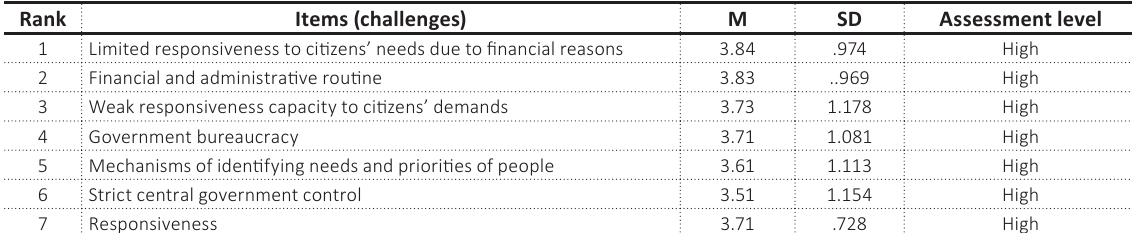
Table 5. Respondents’ assessment of the level of responsiveness facing local government